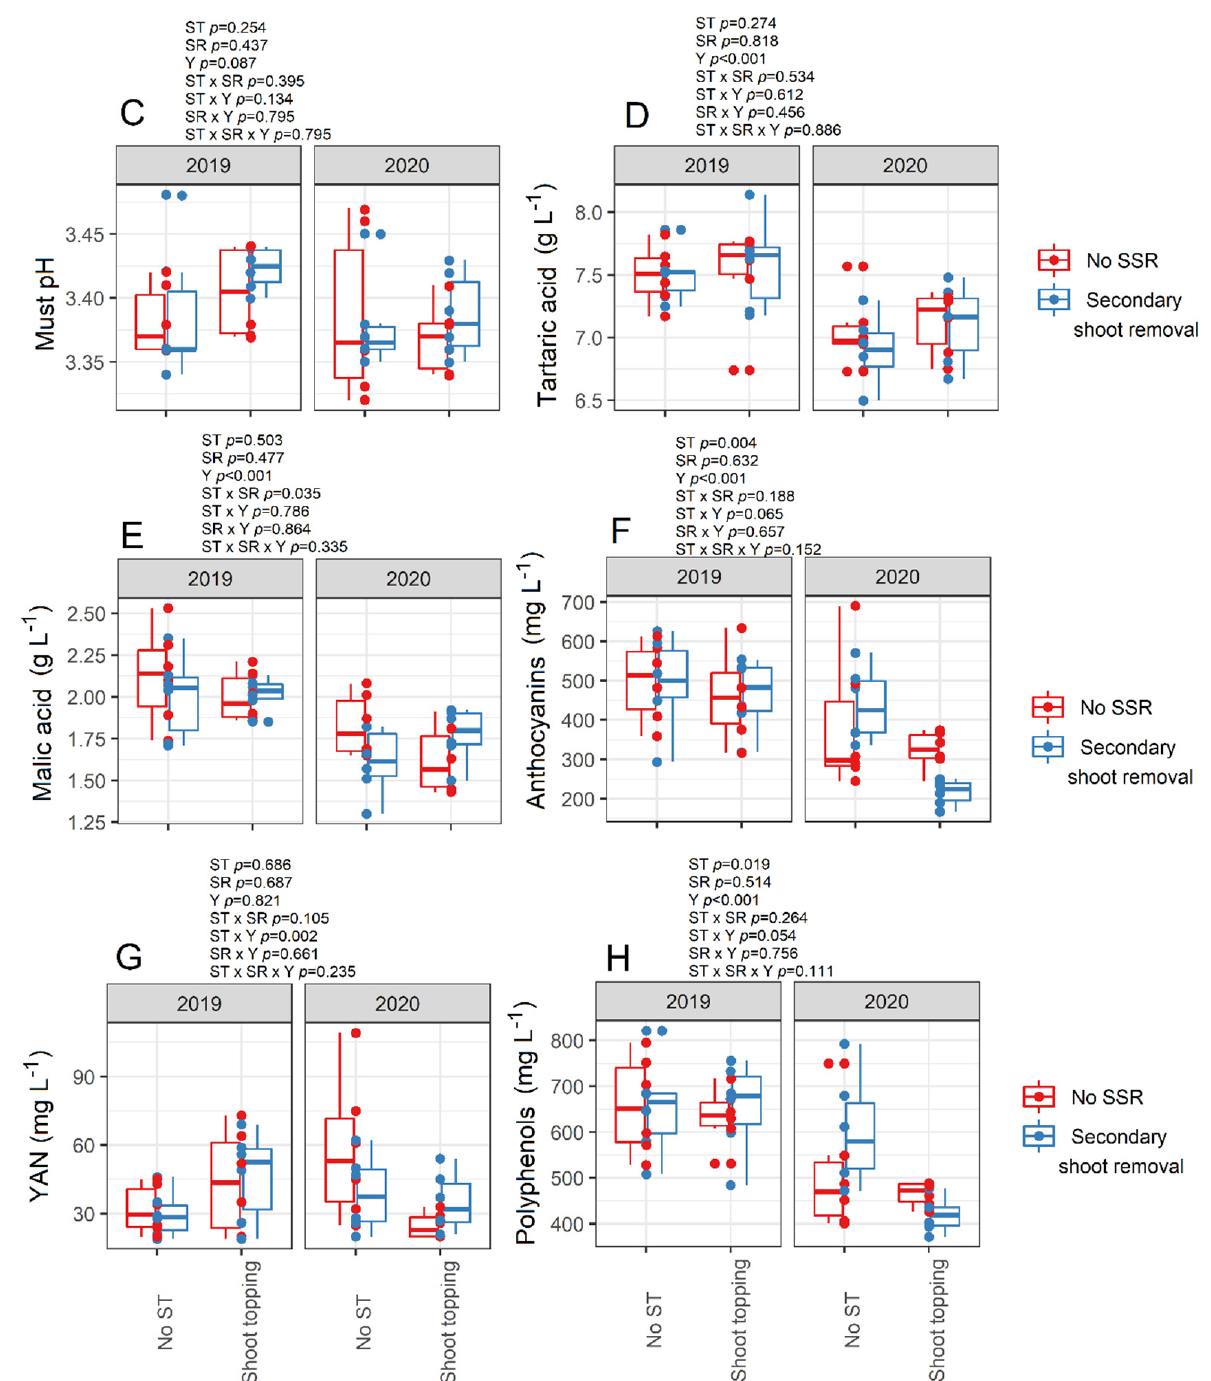
Figure 5. Total soluble solids (TSS, ( A )), titratable acidity ( B ), must pH ( C ), tartaric acid ( D ), malic acid ( E ), total anthocyanins ( F ), yeast available nitrogen ( G ), and total polyphenols ( H ) in plants subjected to shoot topping or shoot bundling (no ST) where secondary shoots were either removed (secondary shoot removal) or not (no SSR) (n = 24). In the graphs, points represent raw data, horizontal lines within boxes indicate the median, and boxes indicate the upper (75%) and lower (25%) quartiles. Whiskers indicate the ranges of the minimum and maximum values. Data were analyzed with three-way ANOVA and p -values are shown in the graph (ST—shoot topping factor; SR—secondary removal factor; ST × SR—interaction).